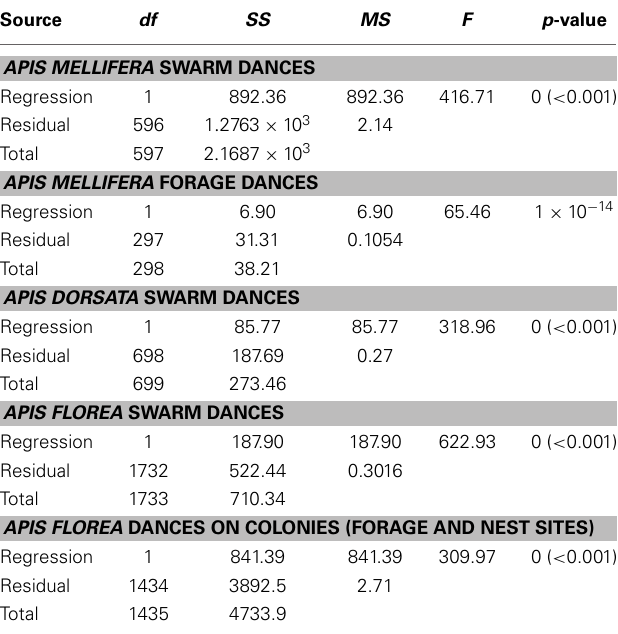
Table 9 | Linear regression statistics, estimated radius of region advertised by dance, R, vs. mean waggle phase duration t (s) (full data